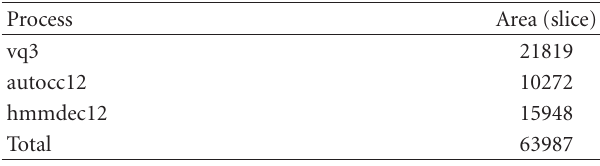
Table 2: Profiling results for major processes of the isolated word recognition system.